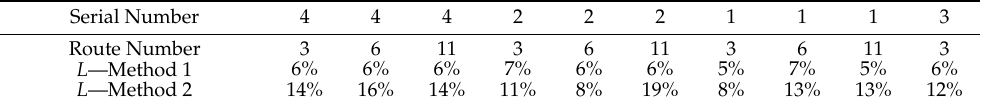
Table A2. Obtained values of the L parameter.